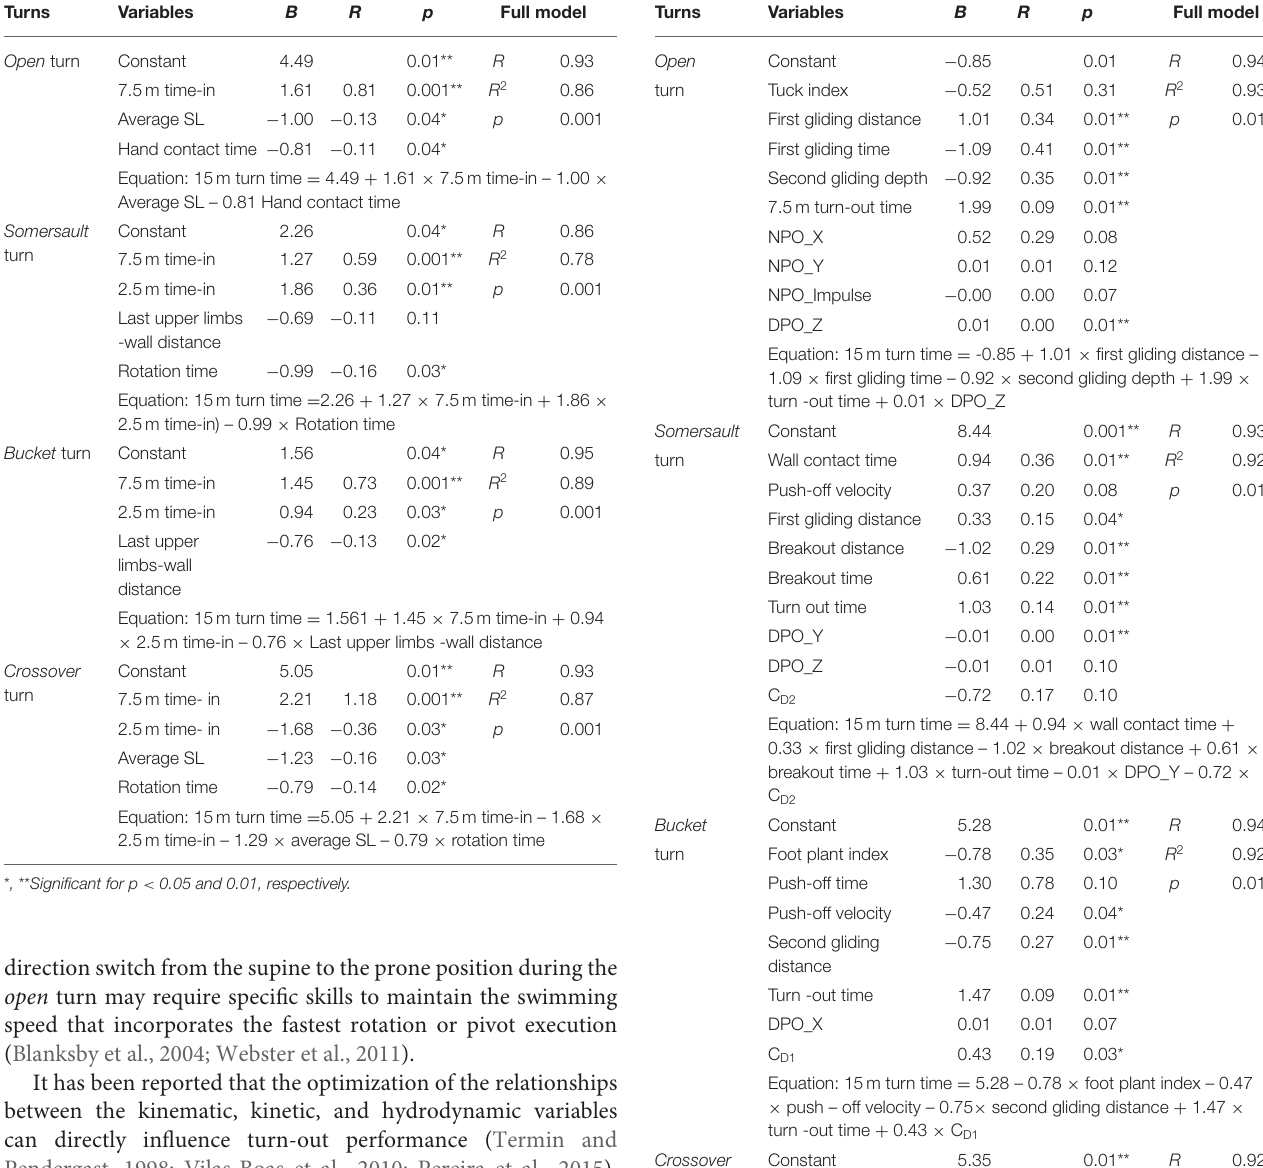
TABLE 5 | Data obtained from multiple regression analysis for turn-out variables. Turns Variables B R p Full model Open Constant −